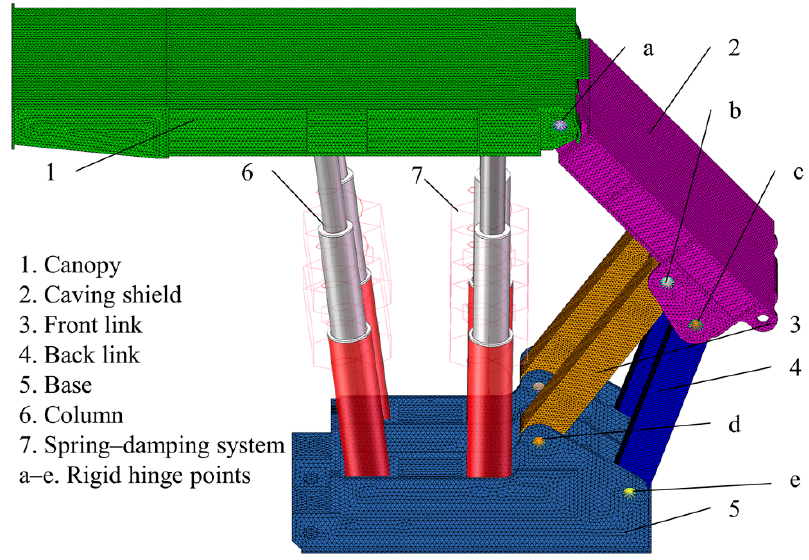
Figure 1. Dynamic model of hydraulic support.